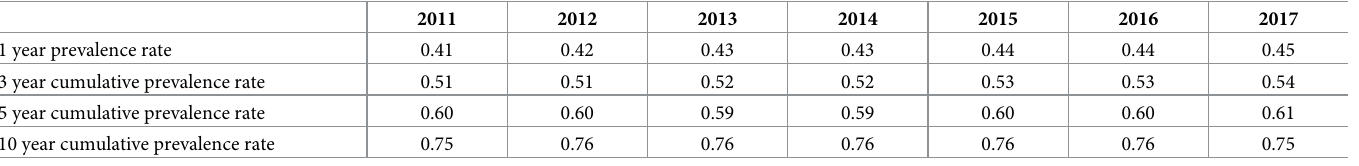
Table 2. 12-month prevalence rate of schizophrenia, schizotypal and delusional disorders,